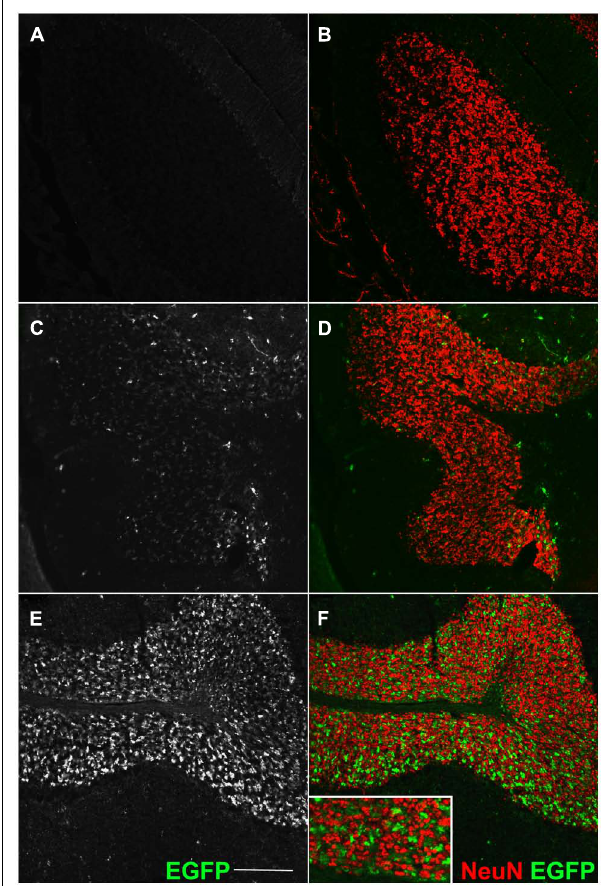
FIGURE 2 |Transgene expression is entirely Cre-dependent. Sagittal sections of an adult cerebellum, immunostained for EGFP (A,C,E) and counterstained for the GC-marker NeuN. (A,B) Double immunofluorescence for GFP and NeuN (granule cells marker) in Cre -negative Rosa26 GFP − VAMP 2 / + mice. Absence of signal confirms the lack of fusion gene transcription in cells which do not express the Cre recombinase. (C–F) Same immunodetection in Syn1-Cre + Rosa26 GFP − VAMP 2 / + mice. (C,D) Lobule I and II; (E,F) lobule IX. EGFP + mossy fiber terminals, originating from Syn1-Cre + neurons in pontine nuclei ( FiguresA1A,B in Appendix), are particularly abundant in posterior lobules (E,F) . Note that EGFP signal (axon terminals) does not overlap with NeuN signal, which decorates the nucleus and cytoplasm of GCs (Leto etal., 2006; Dredge and Jensen, 2011). Scale bar: 150 μ